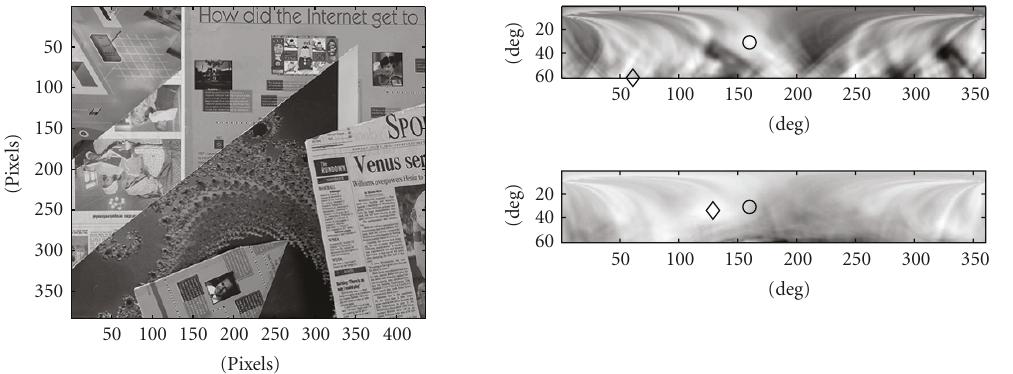
Figure 4: Accuracy evaluation of the patch operator using the first two frames of the “Venus” middlebury sequence. In the left figure, an image of the binocular pair is shown with the target point of the experiment marked by a dot. The right figures show the similarity maps obtained from the two experimental conditions: the top map shows the response of a constant-sized patch and the bottom map shows the response with size-modulation. In these maps, diamonds mark the estimated normal and circles the ground truth. In the experiment, α = 250 length units, baseline was 100 length units, and r = 151. The projection of S subtended ≈ 50pixels in the